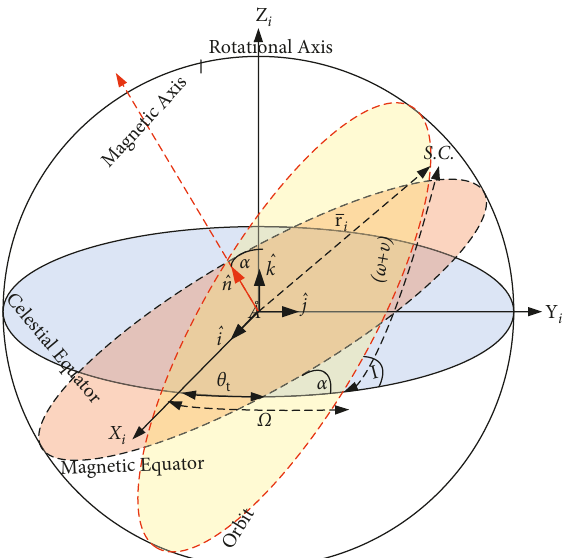
Figure 2: The apparent magnetic axis, rotational axis, and SC orbit in the inertial planet-centric coordinate system on the celestial